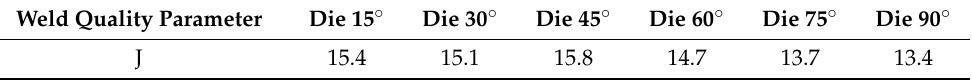
Table 3. The predicted weld quality of porthole die extrusion using different lower bridge angles. Weld Quality